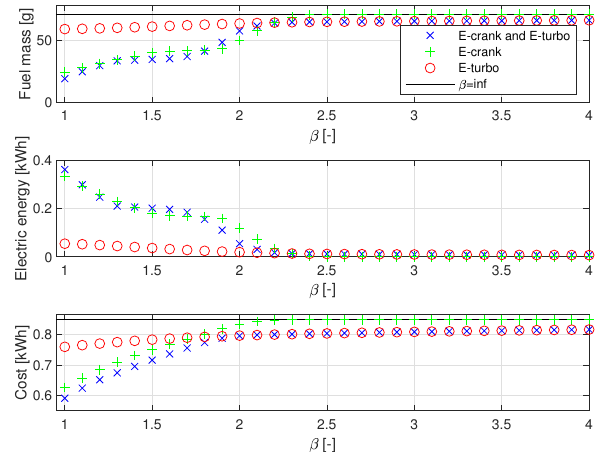
Figure 6. Cost factor β in relation to fuel mass consumed ( top ), electrical energy ( middle ) and optimal control cost ( bottom ). An increasing β corresponds to higher cost of electrical energy. β = inf is the resulting consumed fuel mass if an acceleration is performed without electrical assistance. The cost in the bottom figure is described in